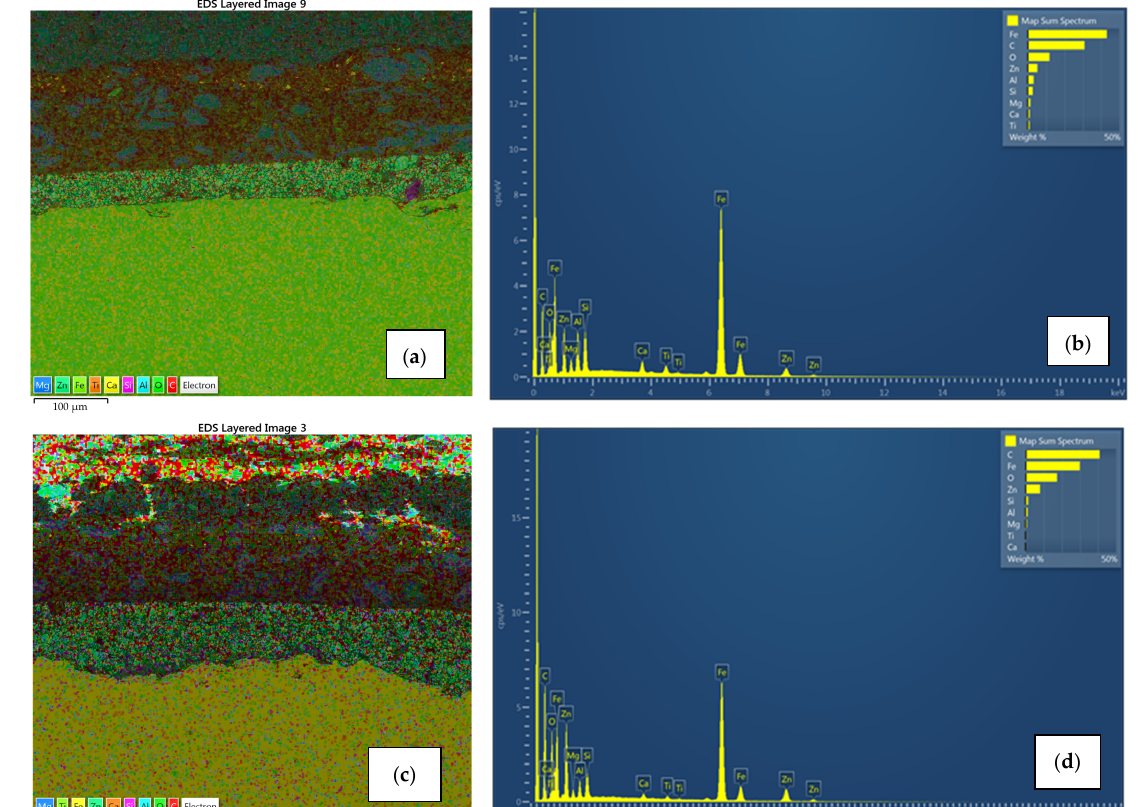
Figure 11. EDX spectroscopy and its elemental mapping for air-dried sample A1 ( a , b ) and IR-dried sample A2 ( c , d ) with distribution for each element. Zn uniformly scattered in the primer in both cases, Ca spread across the intermediate and topcoat layer with Mg-Si-O inclusions, and topcoat pigmented with